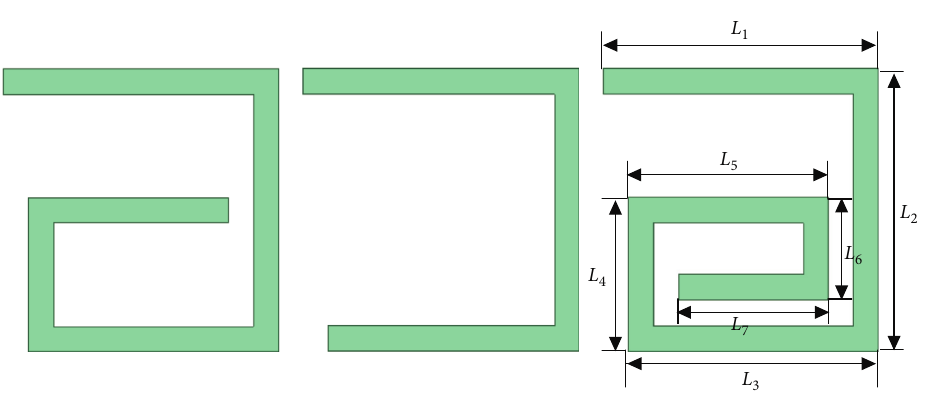
Figure 3: “ 回 ” pane structure